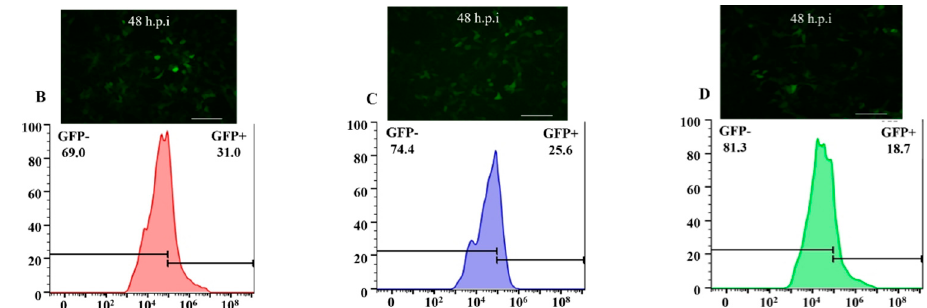
Figure 8. Efficiency of transducing 293T cells by AcBV with envelope modification. ( A ) Measure the number of 293T cells expressing green fluorescence by flow cytometry. ( B ) Measure the number of 293T cells expressing green fluorescence by flow cytometry, which the AcBV- Δ gp64-pie1-invasin- 64orf-p64-gfp-ires-gp64 infected for 48 h. ( C ) Measure the number of 293T cells expressing green fluorescence by flow cytometry, which the AcBV- Δ gp64-pie1-vsvg-p64-gfp-ires-gp64 infected for 48 h. ( D ) Measure the number of 293T cells expressing green fluorescence by flow cytometry, which the AcBV- Δ gp64-p64-gfp-ires-gp64 infected for 48 h (as control).